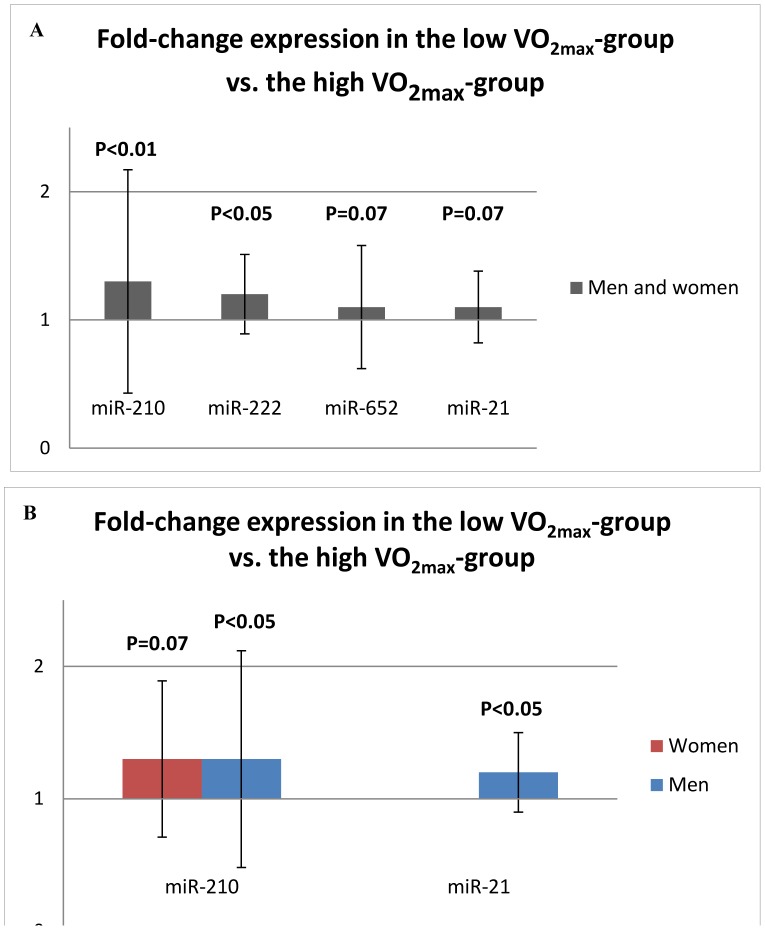
MicroRNAs with significant (or borderline significant) up-regulation in serum samples from subjects with low aerobic fitness compared to subjects with high aerobic fitness.A: In both men and women (n = 76), B: Both gender analyzed separately (n = 38 men, n = 38 women). VO2max: Maximal oxygen uptake. Error bars represent 1 standard deviation.